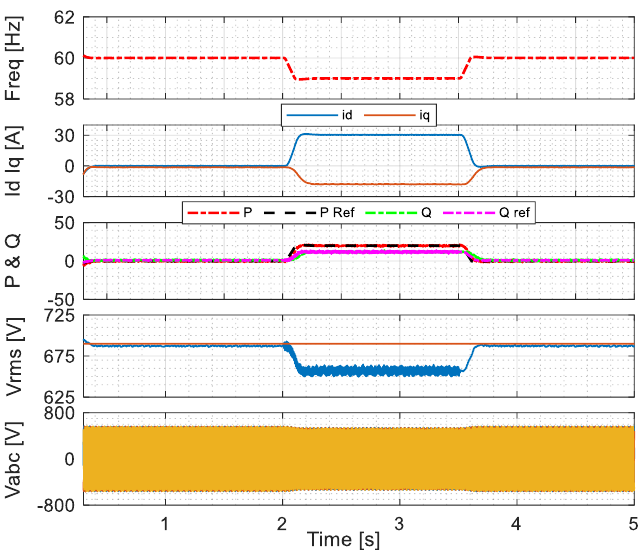
Figure 9. PCC voltage control operation results.